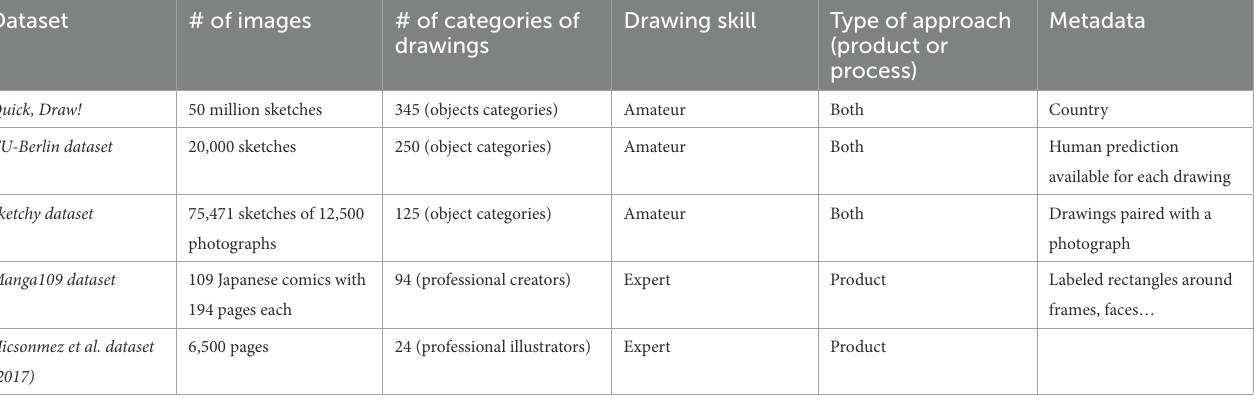
TABLE 2 Summary of the presented